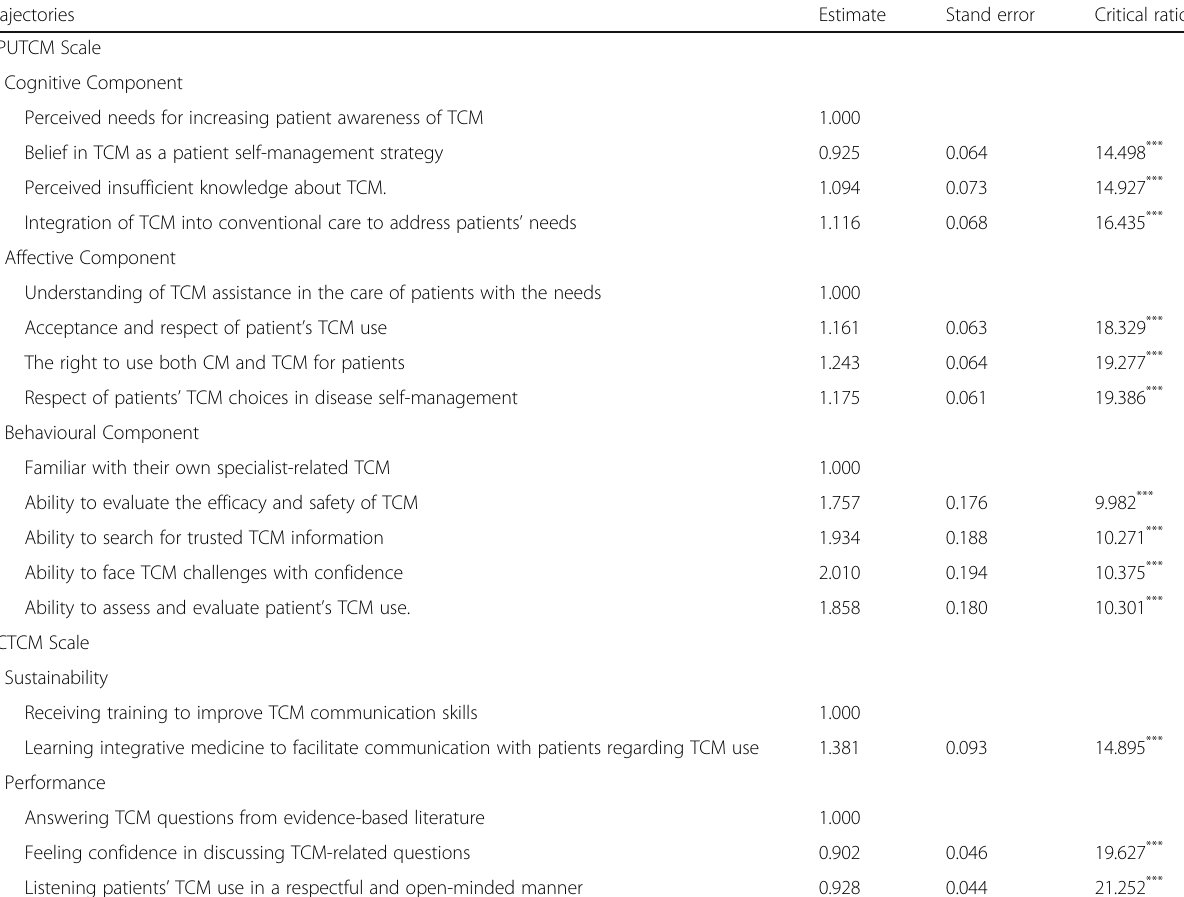
Table 2 Trajectories and critical ratios of the APUTCM and CCTCM scales